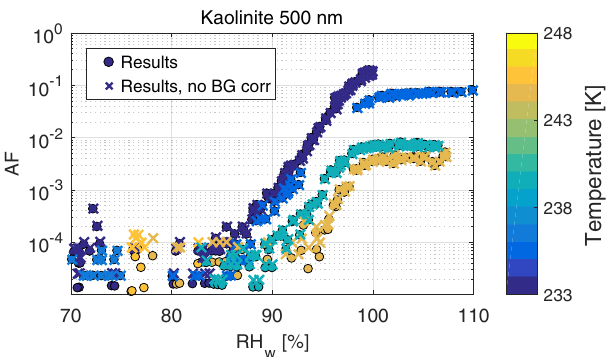
Figure D1. Activated fraction results of PINC, including back- ground correction (circles) as shown in Fig. 7 and raw data without accounting for background counts